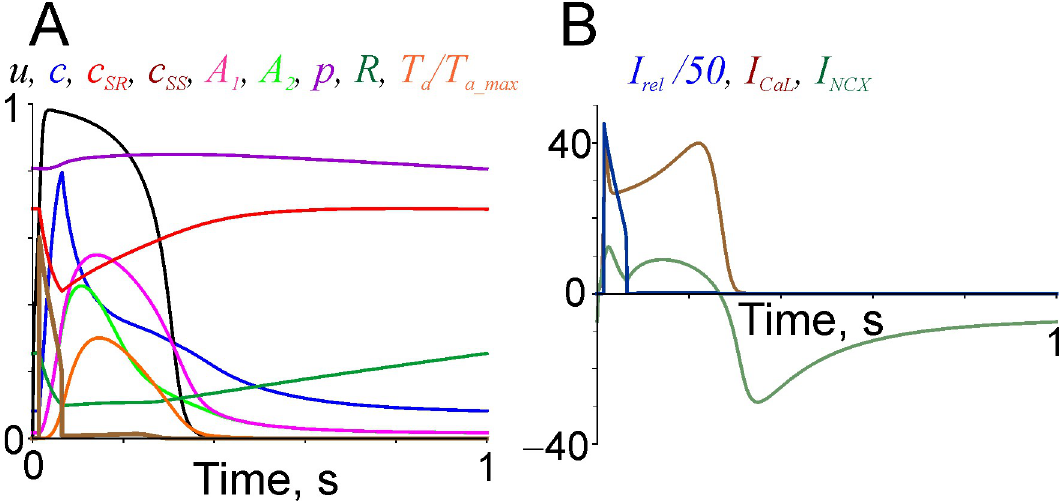
Fig 2. The time courses of model variables and major Ca 2+ flows during a twitch contraction at constant sarcomere length of 2.2 μ m and stimulation rate of 1 Hz. A: u , c (in μ M), c maximal isometric value at saturating Ca 2+ concentration at the same sarcomere length); B: I NCX , I CaL , and I rel /50 (in μ M × s − 1